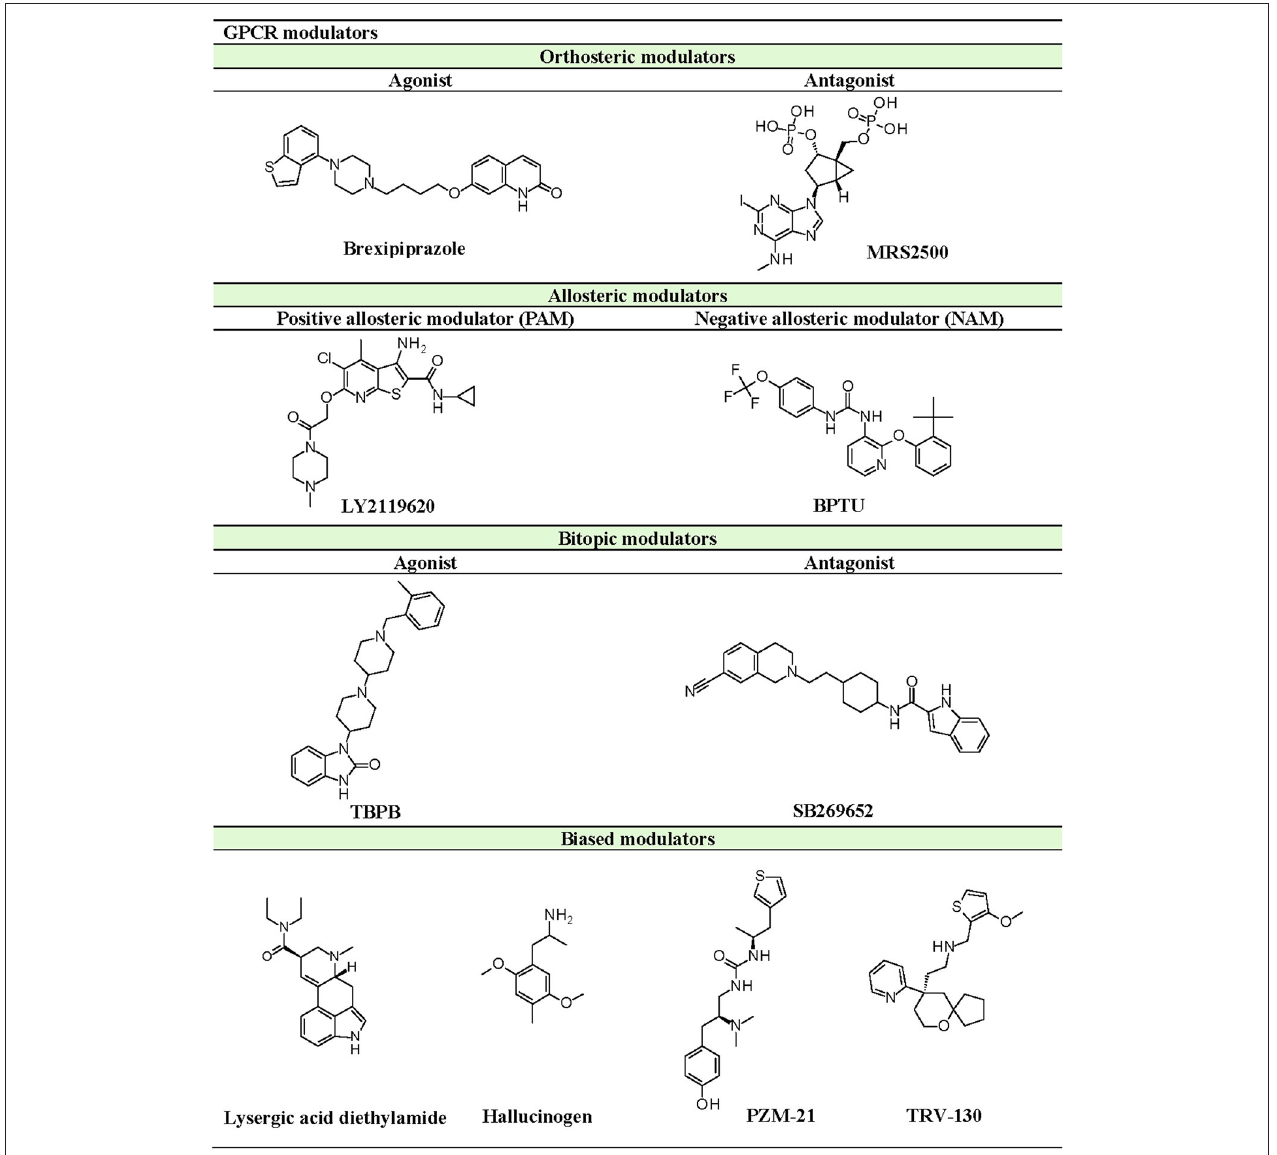
FIGURE 4 | Representative chemical structures of various GPCR